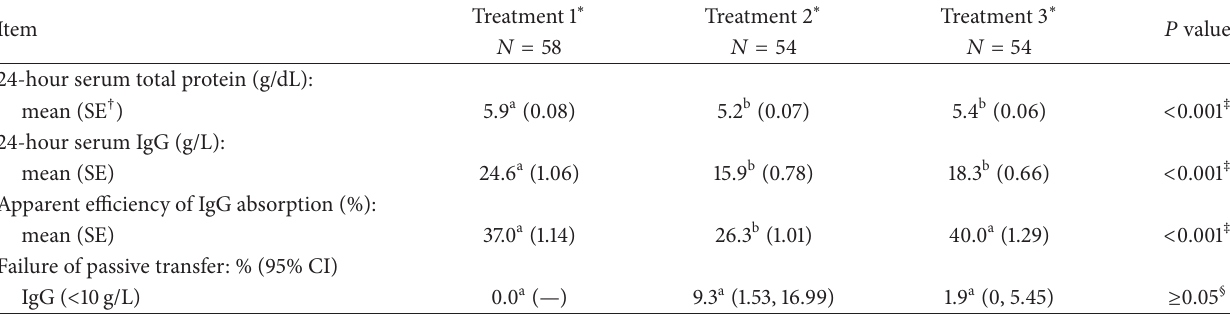
Table 2: Effect of treatment on 24-hour serum total protein and IgG concentrations, apparent efficiency of IgG absorption, and passive transfer status of Holstein and Jersey calves in a randomized field trial comparing the effect of feeding either first-milking pooled colostrum alone or first-milking pooled colostrum followed by either a colostrum-derived replacer or second-milking pooled